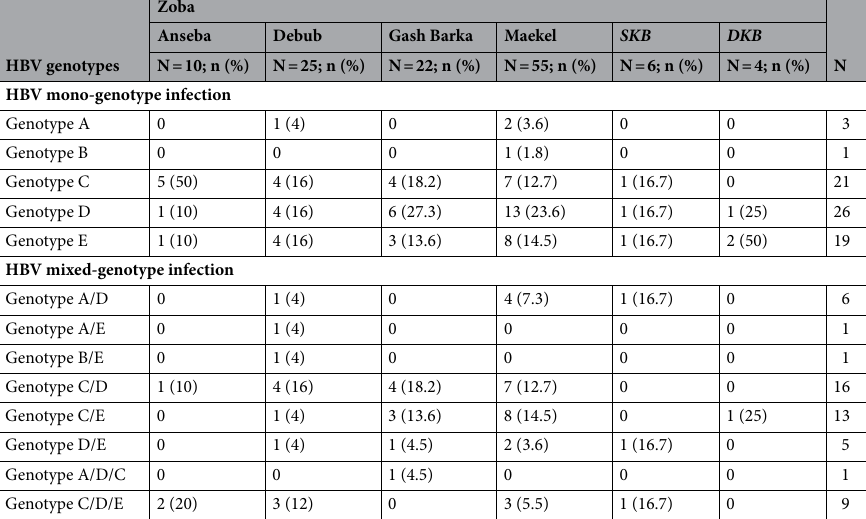
Table 5. Distribution of different HBV genotypes in different Zobas of